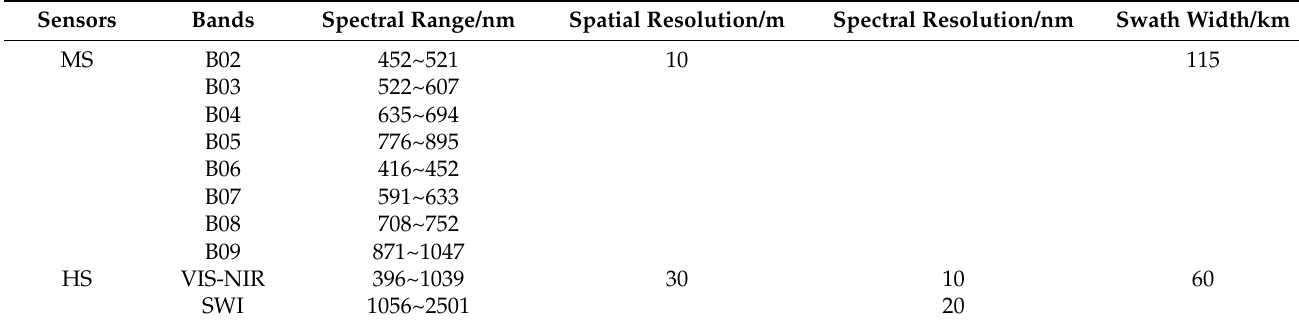
Table 1. Parameters of ZY-1 02D hyperspectral and multispectral sensors.